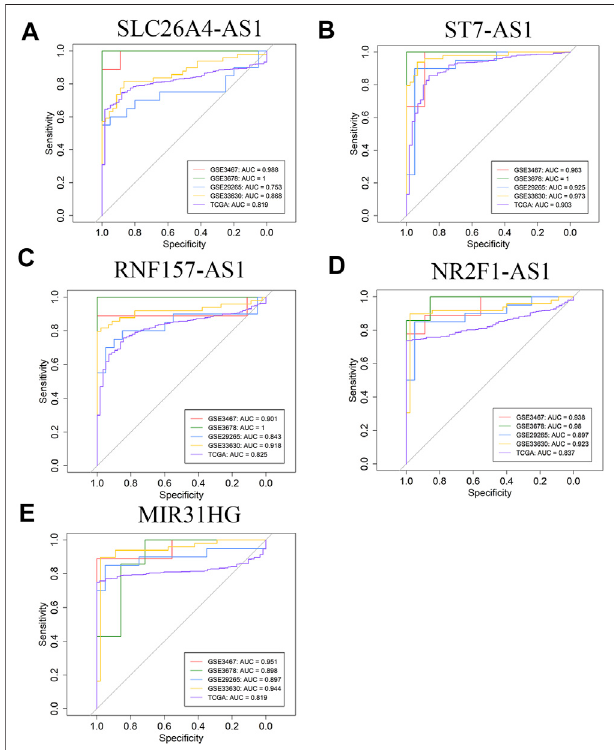
FIGURE 3 | ROC curve analysis of fi ve hub lncRNAs diagnosis in GSE3467, GSE3678, GSE29265, GSE33630, and TCGA cohort. (A)